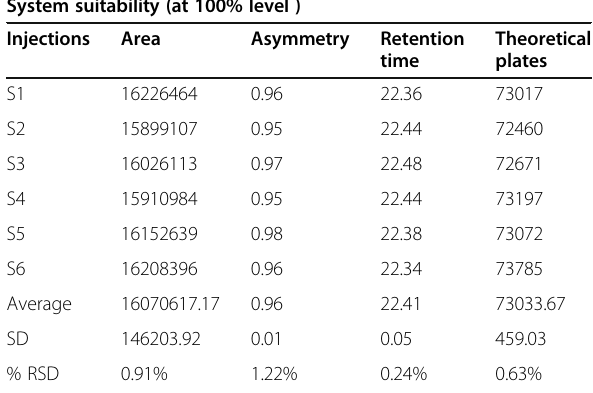
Table 5 Results of within batch precision study